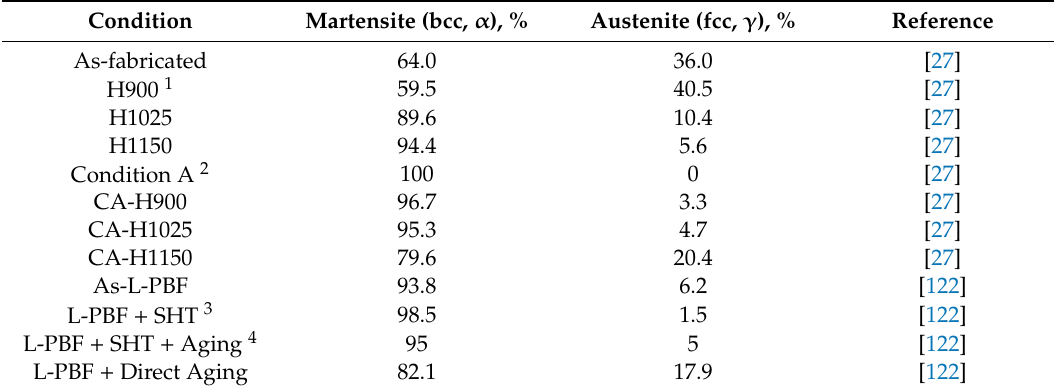
Table 4. The e ff ect of heat treatment conditions on the amount of austenite (material: 17–4 steel).